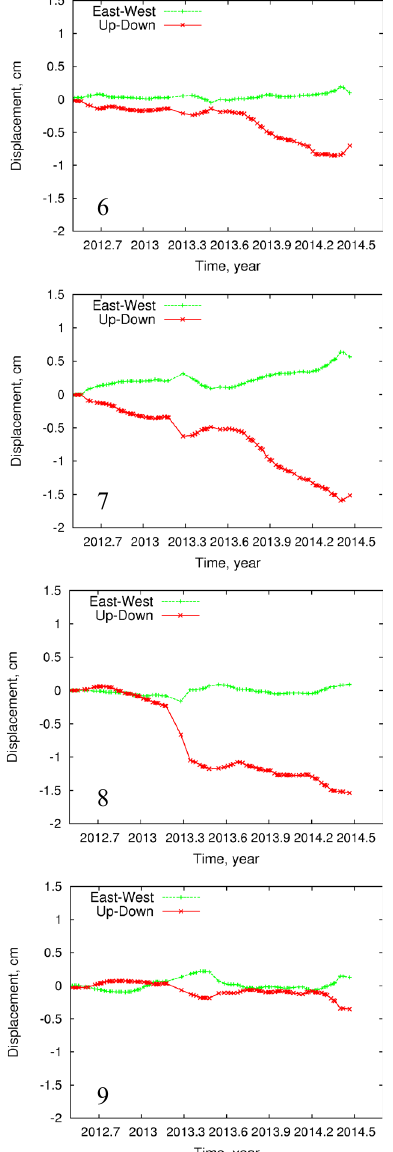
Figure 7. Time series for selected sites located in Figure 5 and numbered from 1 to